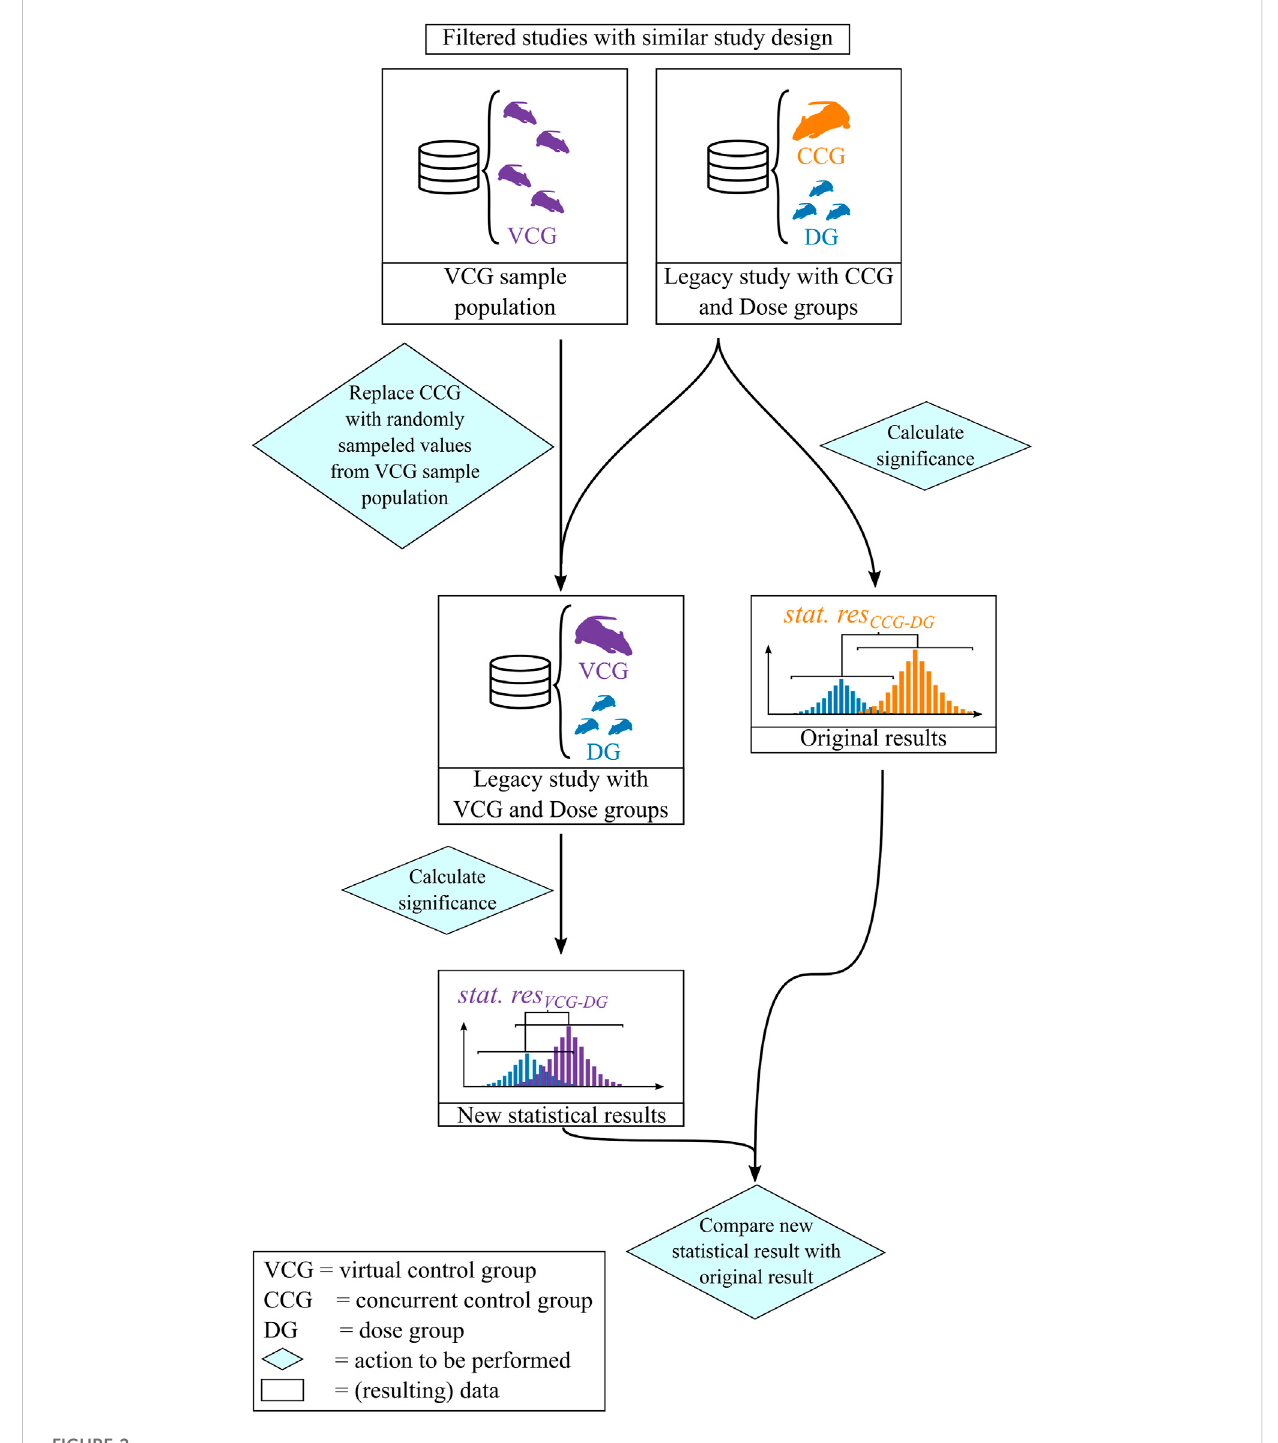
FIGURE 2 Work fl ow of assessing the performance of